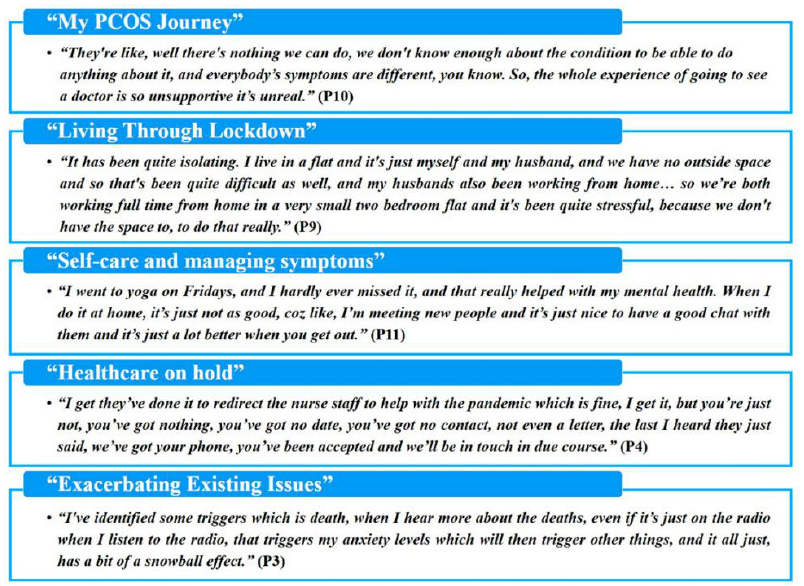
Figure 1. List of the five main themes that were derived from the study dataset with illustrative quotes (P: participant).